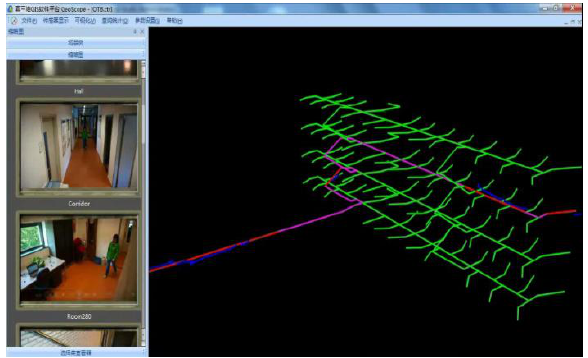
Figure 5 the result of 3D indoor path tracking. (the purple line denotes the derived